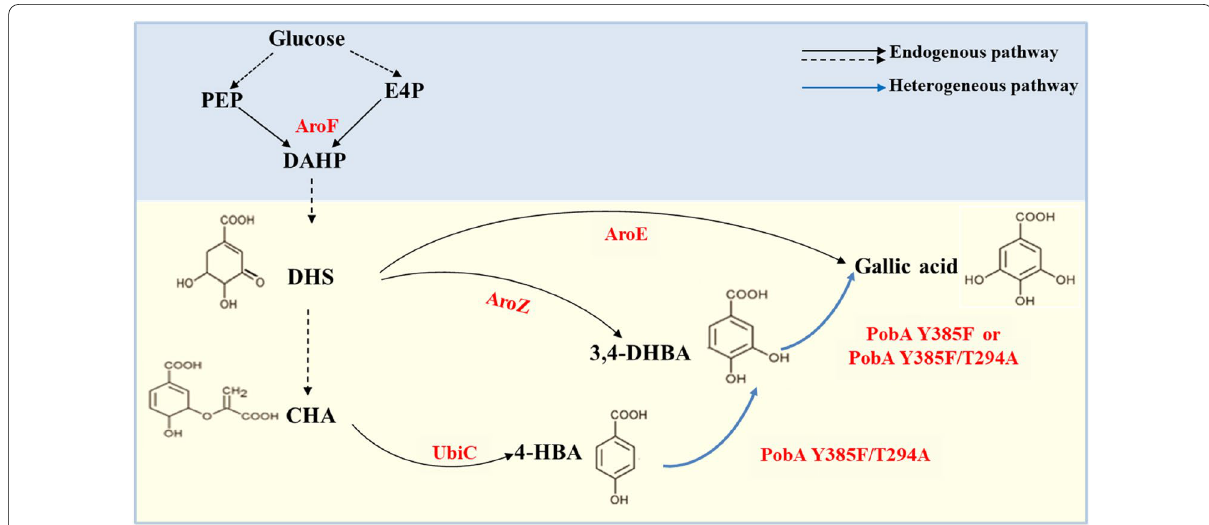
Fig. 1 Gallic acid endogenous pathway and heterogeneous pathway of E. coli. E4P erythrose 4-phosphate, PEP phosphoenolpyruvate, DAHP 3-deoxy-d-arobino-heptulosonate 7-phosphate, DHS 3-dehydroshikimate, CHA chorismate, 4-HBA 4-hydroxybenzoic acid, 3,4-DHBA protocatechuic acid, AroF 3-deoxy-7-phosphoheptulonate synthase, AroZ 3-dehydroshikimate dehydratase, AroE shikimate dehydrogenase, UbiC chorismate